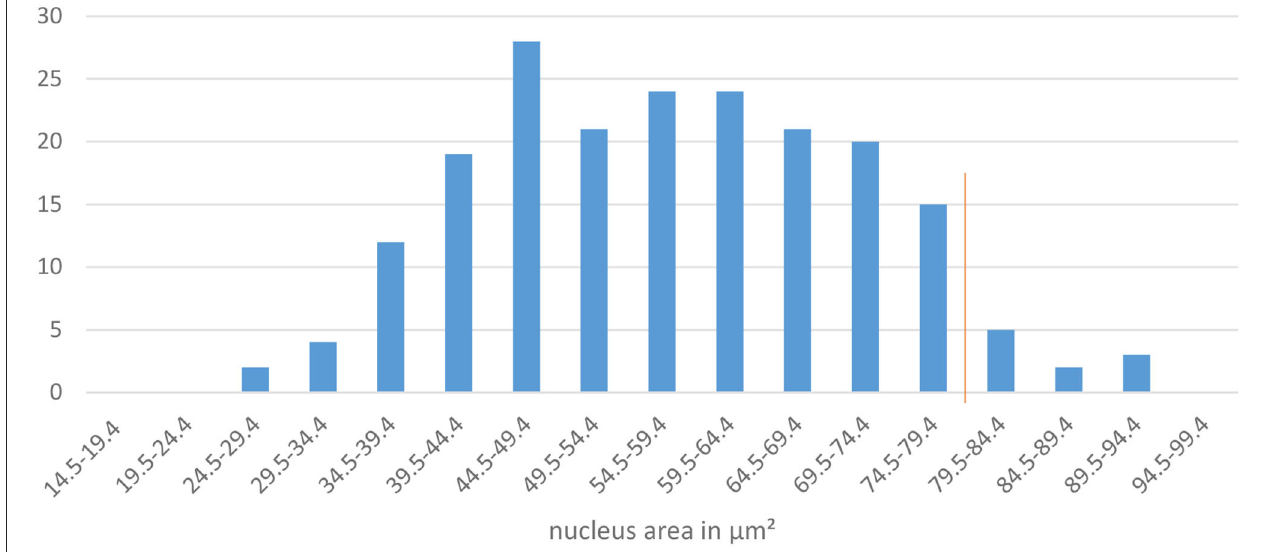
FIGURE 4 | The diagram shows the area of the measured nuclei of cornified vaginal cells in µ m ² and the frequency of measurements. The red line marks the 95